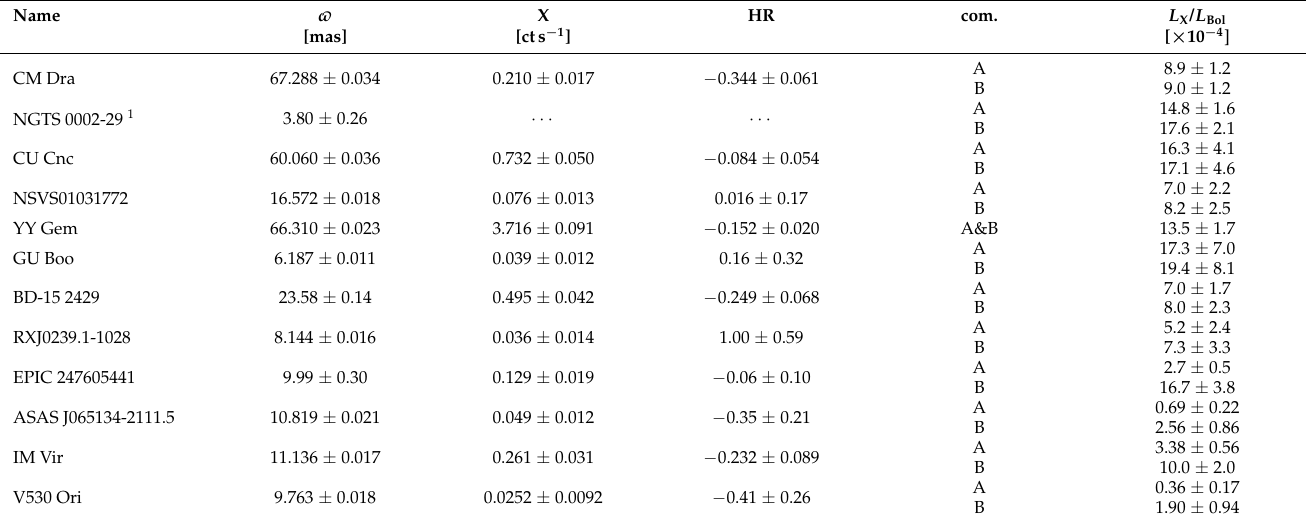
Table 2. List of DLEBs with X-ray data and parallax determination from